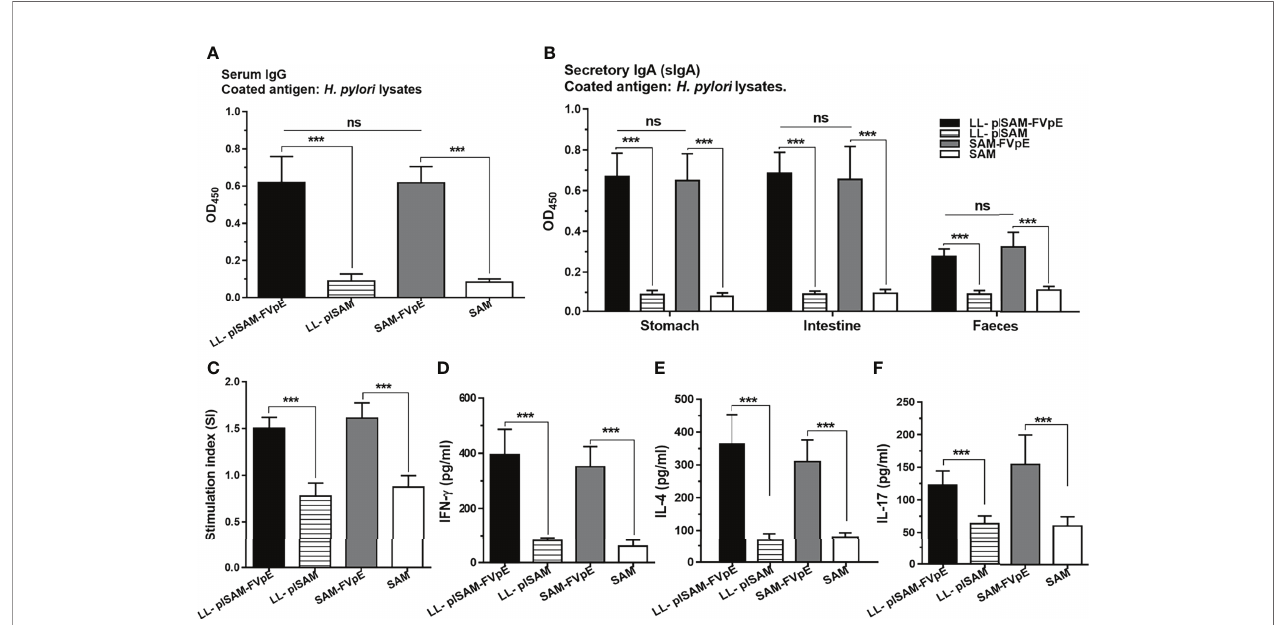
FIGURE 8 | ( H ) pylori -speci fi c antibodies and cellular immune responses after therapeutic immunization with LL-plSAM-FVpE. (A) Serum IgG antibodies. ( H ) pylori - speci fi c serum IgG antibodies were determined by indirect ELISA. ***p <0.001, ns not signi fi cant. (B) Mucosal sIgA antibodies. ( H ) pylori -speci fi c mucosal sIgA antibodies in the gastrointestinal tract were detected by indirect ELISA. ***p <0.001, ns not signi fi cant. (C) Proliferative response of T lymphocytes. After stimulation with ( H ) pylori lysates, the proliferation of splenic T lymphocytes was examined. ***p <0.001. (D – F) Analysis of the cytokines. After stimulation with ( H ) pylori lysates, cytokines (IFN- g , IL-4 and IL-17) were analyzed by ELISA. ***p